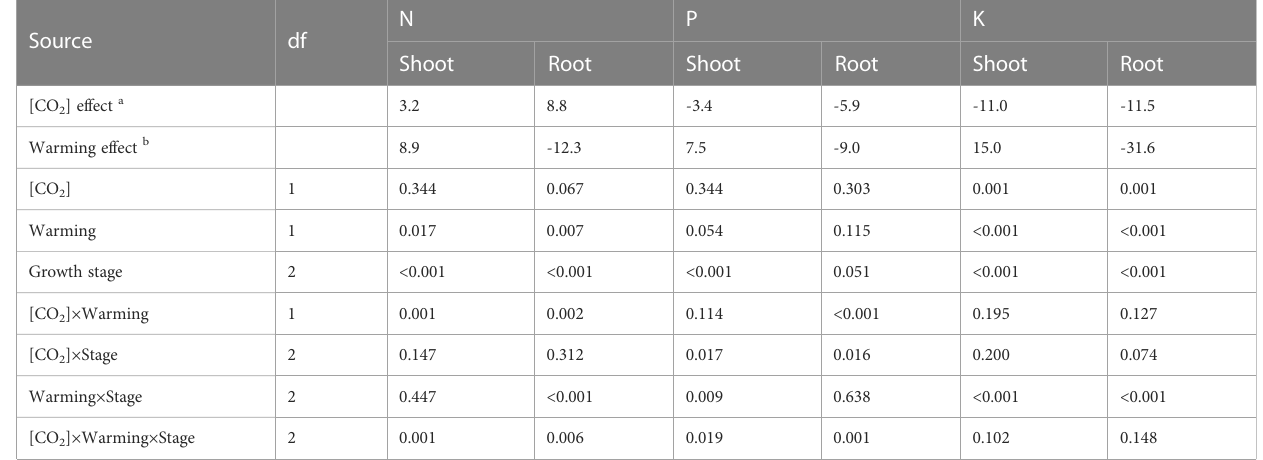
TABLE 1 Summary of the GLMM analysis of nutrient concentrations in shoots and roots under simulated climate change